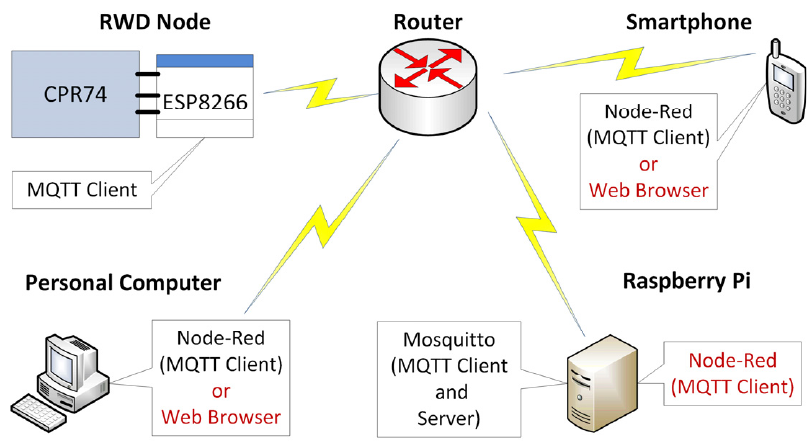
Figure 1. Architecture of development platform.